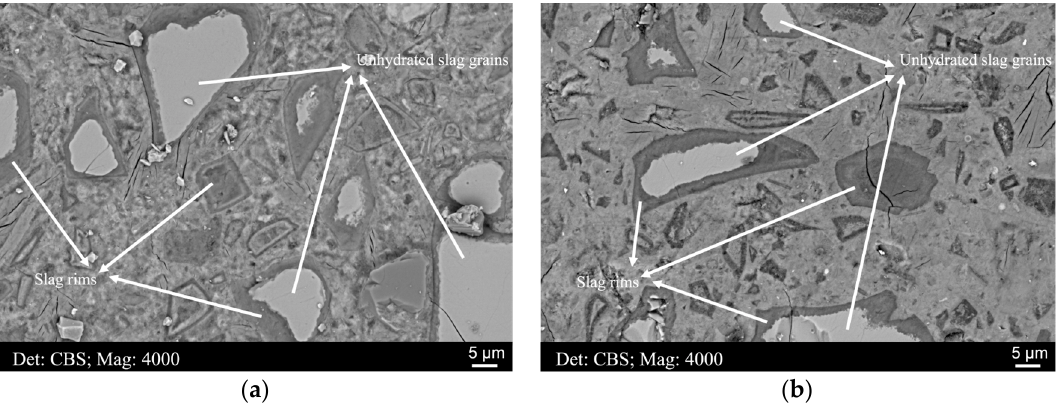
Figure 2. The microstructures of ( a ) sample A and ( b ) sample B,